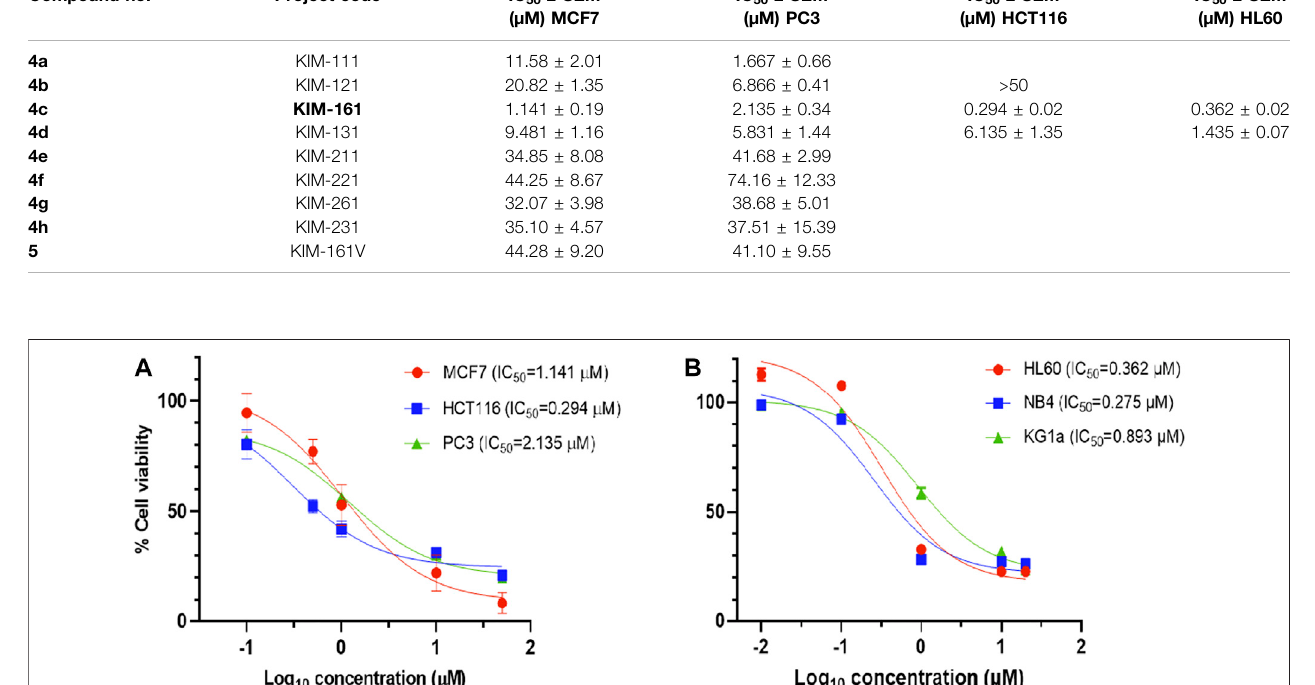
TABLE 1 | List of IC 50 ± SEM values of different compounds against a panel of cancer cell lines. Compound no.